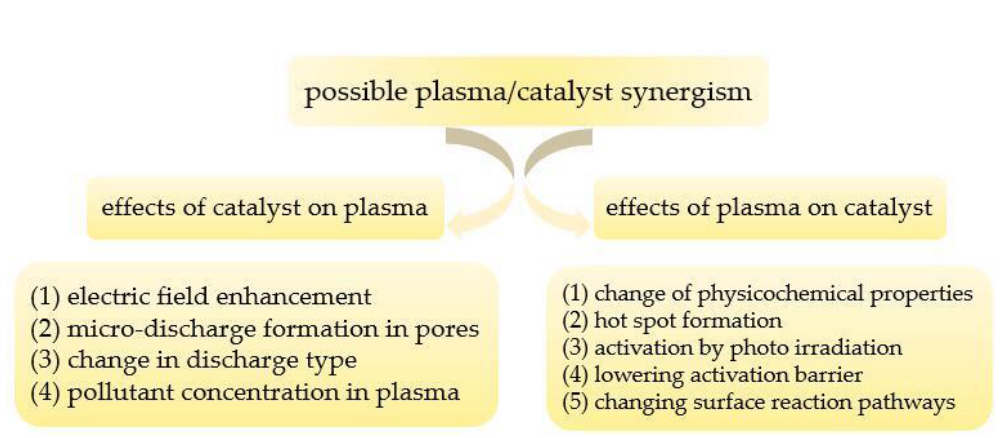
Figure 19. Overview of the possible effects of the catalyst on the plasma and vice versa, possibly leading to synergism in plasma-catalysis, reproduced with permission from [13]. Copyright Royal Society of Chemistry, 2017.